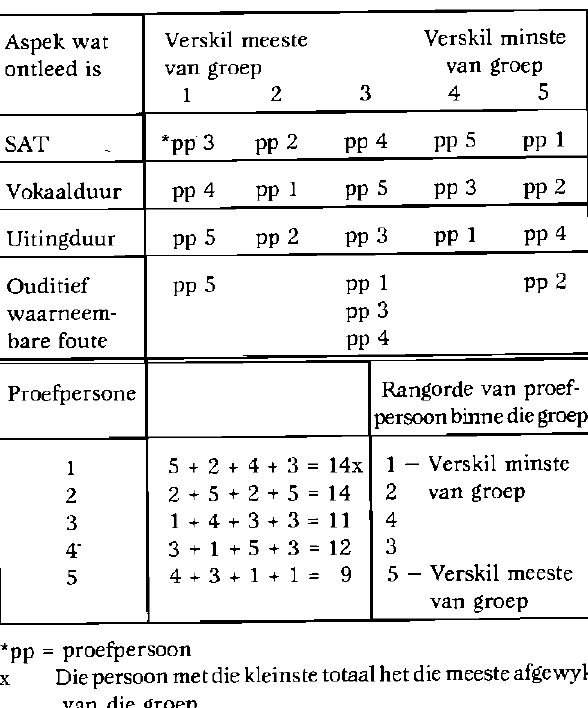
Tabel 1: Proefpersone gerangskik in volgorde van afwyk- ing vanaf die groepgemiddeldes vir SAT, vokaal- duur, uitingduur en ouditief waarneembare foute Aspek